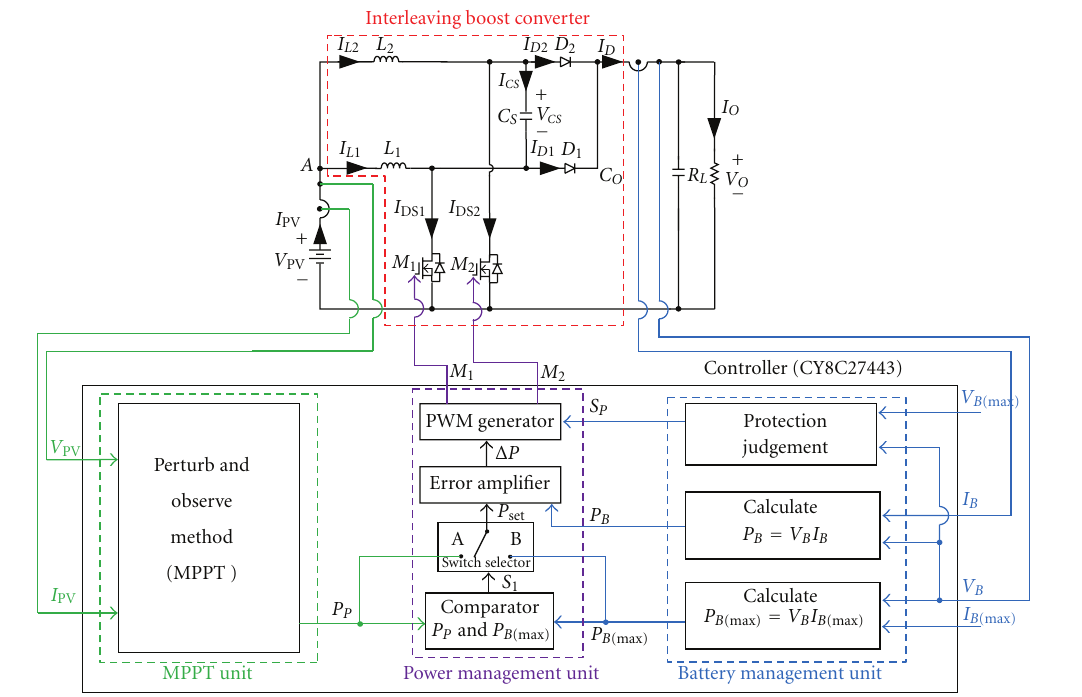
Figure 14: Block diagram of the proposed battery